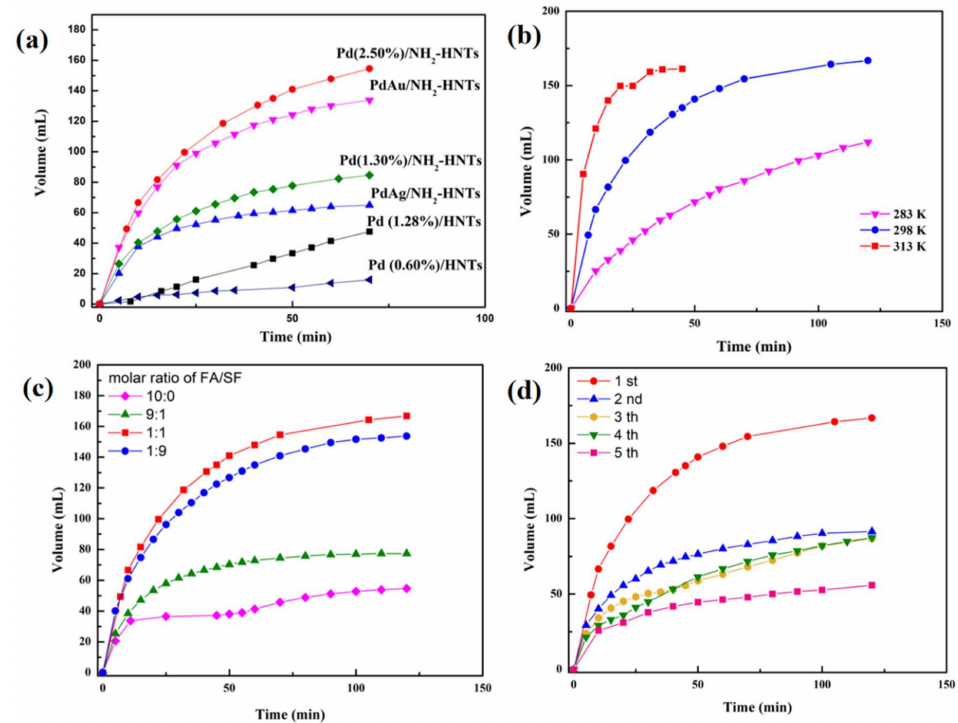
Figure 5. ( a ) H 2 volumes generated in DFA reactions of solution with FA/SF = 1 over catalysts at 298 K. ( b ) Hydrogen generation over the catalyst Pd/NH 2 -HNTs with FA/SF = 1 at 283, 298 and 313 K; ( c ) with different FA/SF molar ratios at 298 K. ( d ) Recyclability results of Pd/NH 2 -HNTs used in